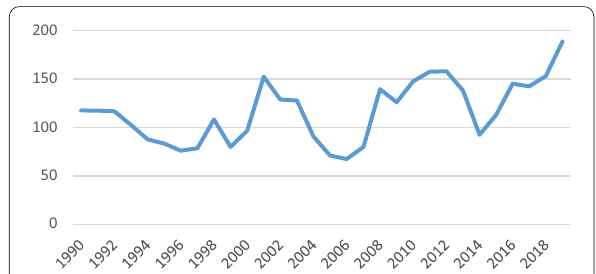
Fig. 1 Time Trend of U.S. EPU. Source Research